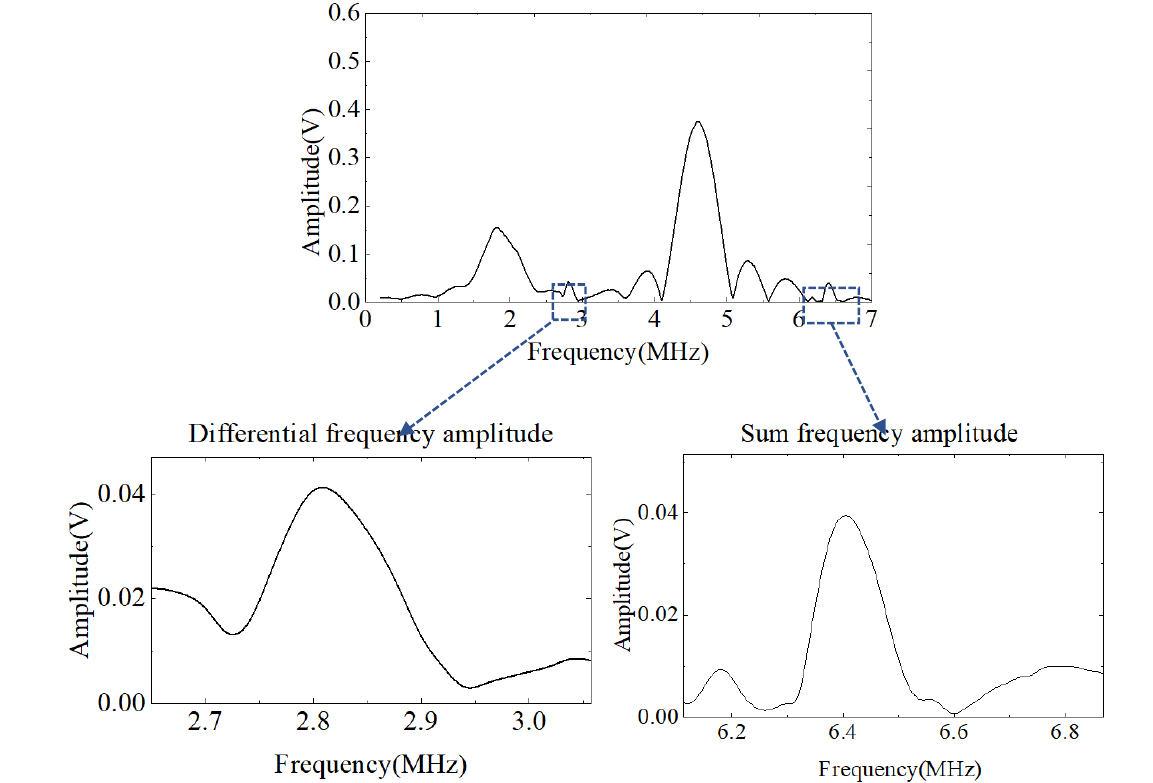
Figure 21. 6 # specimen received signal spectrum diagram. Figure 21. 6# specimen received signal spectrum diagram.